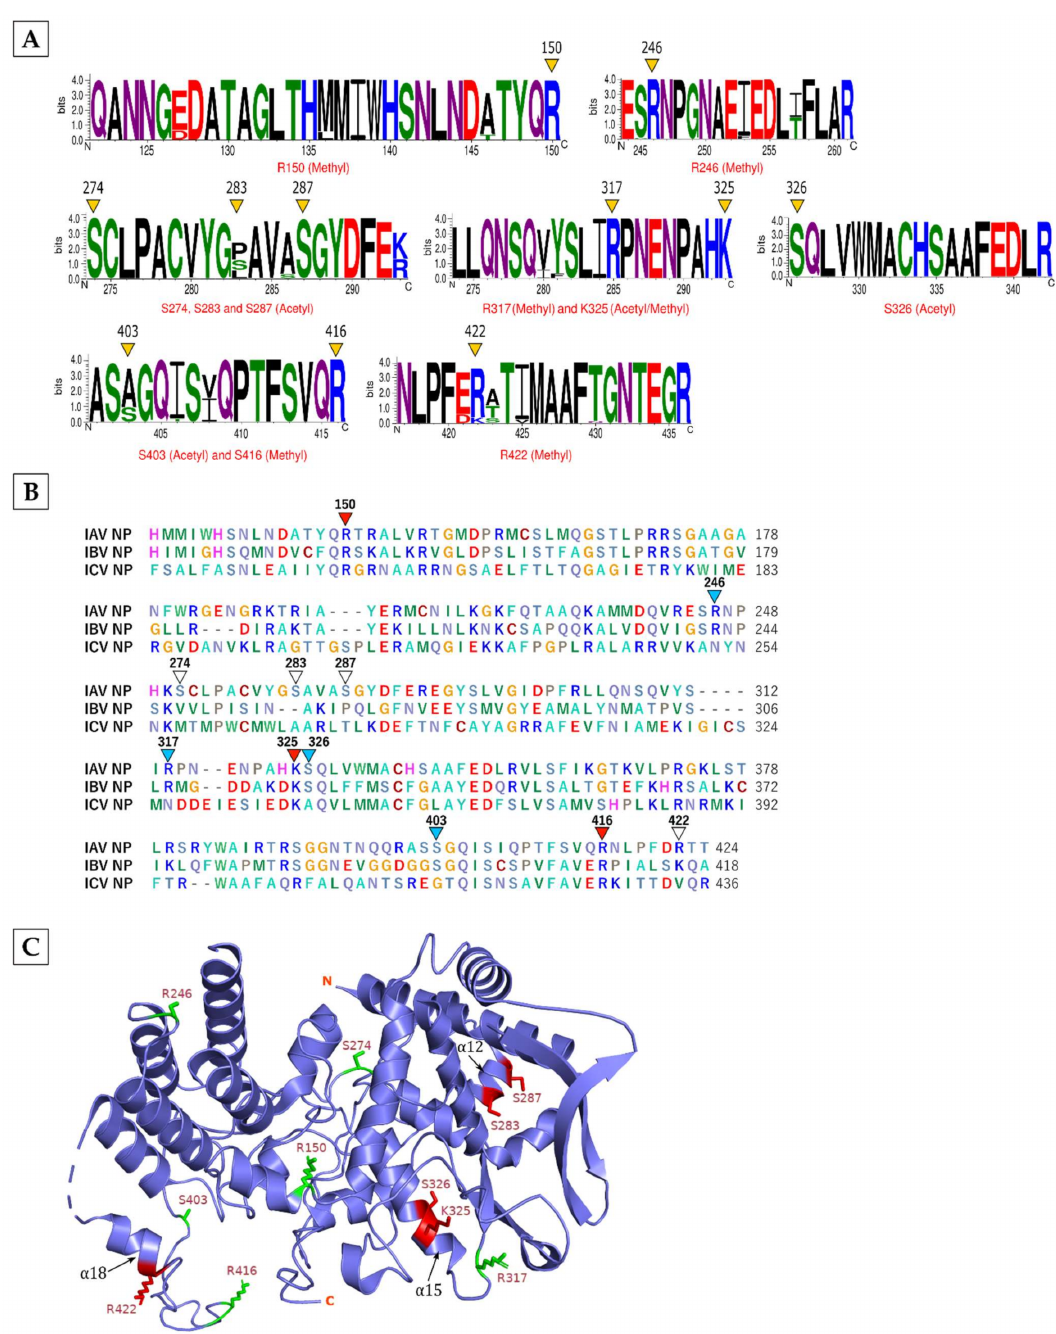
Figure 2. The characteristics of the modifications on IAV nucleoprotein (NP). ( A ) Conservation of modified residues across NP of IAV subtypes. A total of 1,124 sequences from 42 different IAV subtype strains were aligned in BioEdit using ClustalW and visualised by WebLogo. The logos represent individual peptides with modified residues (yellow arrowheads). The X -axis indicates the position of amino acid and the Y -axis indicates the bit score on a scale of 1–4 (A scale of 4 means 100% conservation). Acetyl: acetylation, Methyl: methylation. ( B ) Conservation of modified residues across NP of IAV, IBV, and ICV. Red arrowheads point to conservation in all three influenza virus types, turquoise arrowheads point to conservation in IAV and IBV, and white arrowheads point to no conservation. ( C ) Location of modified residues in the NP structure. Red atom stick indicates the location on α -helix regions, green atom stick indicates the location on loop regions. N, N-terminal domain; C, C-terminal